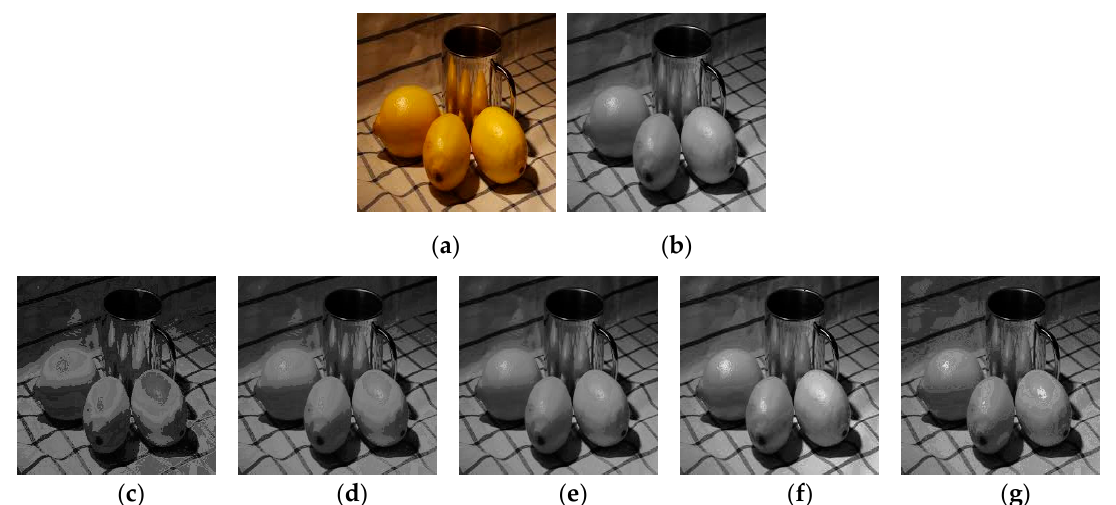
Figure 13. RGB to grayscale results. ( a ) Input image. ( b ) Exact output. ( c ) 1st design. ( d ) 2nd design. ( e ) 3rd design. ( f ) 4th design. ( g ) 5th design.